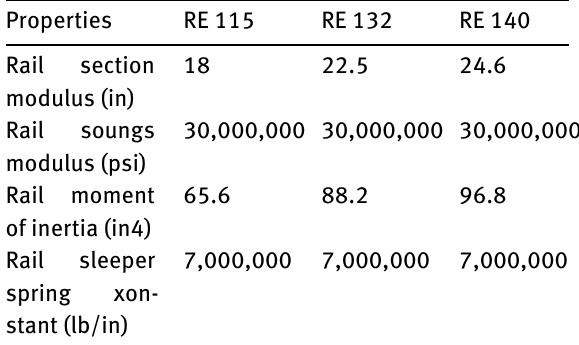
Table 3: Rail Properties of RE 115, RE 132, RE 140.